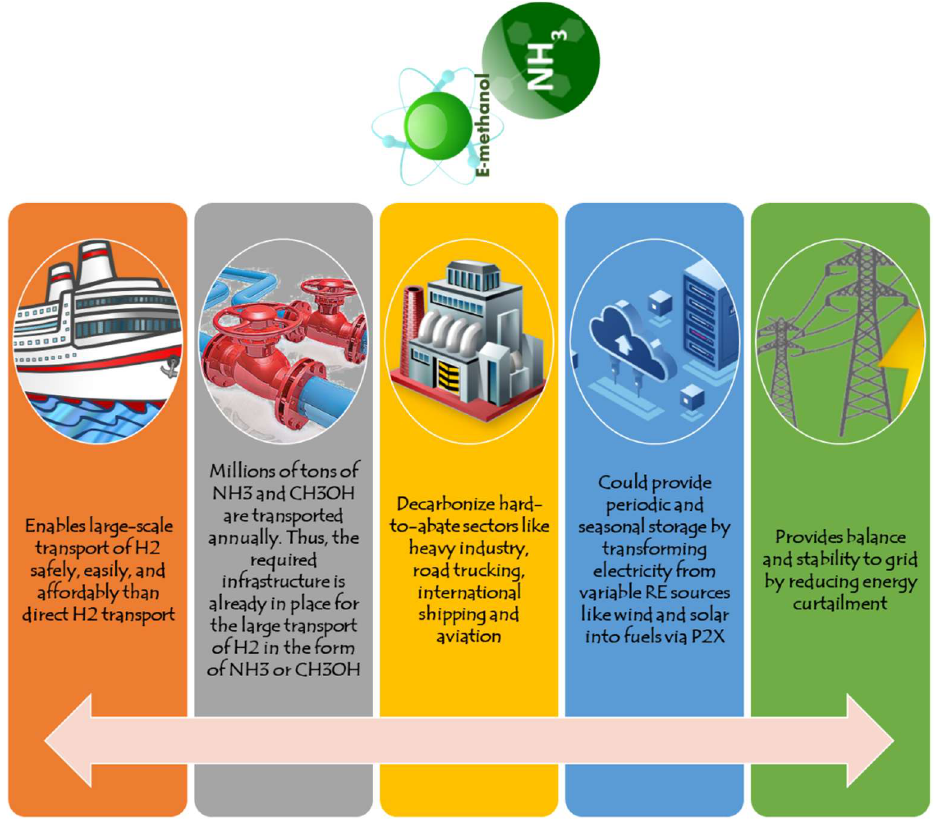
Figure 9. Role of green ammonia and methanol in a carbon-neutral future.